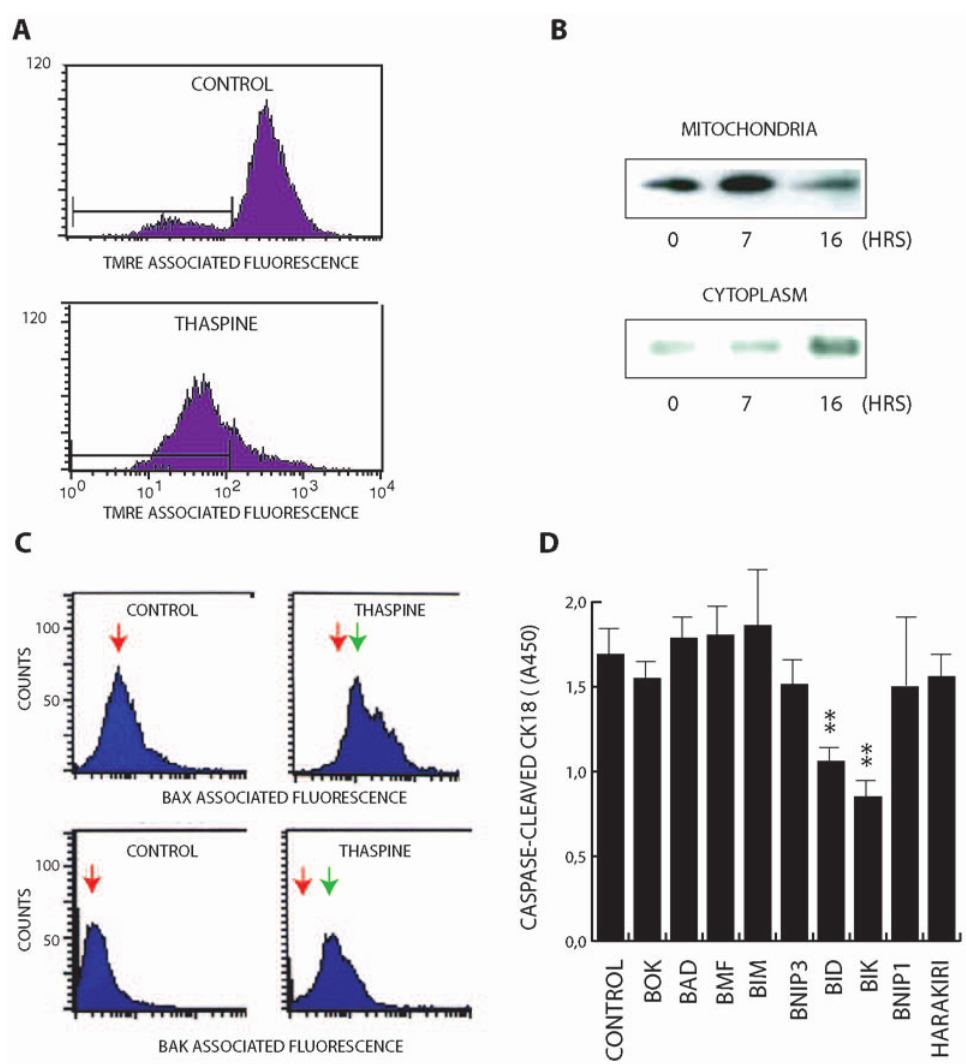
Figure 3. Induction of the mitochondrial apoptosis pathway by thaspine. (A) loss of mitochondrial membrane potential in thaspine-treated HCT116 cells. Control and thaspine-treated cells (10 m M, 18 hours) were stained with tetramethyl-rhodamine ethyl ester (TMRE) and fluorescence was measured by flow cytometry; (B) Release of cytochrome c to the cytosol of thaspine-treated cells. Cells were treated with 10 m M thaspine for 7 or 16 hours. Cytochrome c was quantified in mitochondrial and cytosolic fractions by Western blotting. (C) thaspine induces the active conformation of Bak and Bax. Cells were treated with 10 m M thaspine, fixed and stained with conformation-specific antibodies to Bak and Bax. Note induction of the active conformation of both molecules by thaspine ( red arrows : immunofluorescent signal in untreated cells; green arrows : immunofluorescent signal in drug-treated cells). (D) Inhibition of thaspine-induced apoptosis by siRNA to Bik and Bid. Cells were transfected with siRNAs in triplicate 96 well plates and treated with thaspine or solvent (see Material and Methods). After 24 hours the levels of caspase-cleaved CK18 were determined using the M30 CytoDeath ELISA.